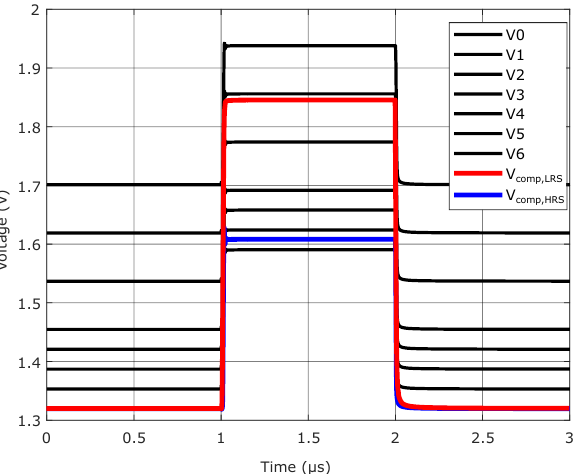
Figure 9. Simulation results read circuit with two different states.